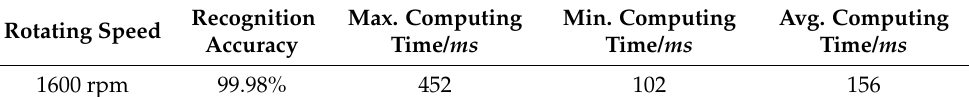
Table 3. Recognition accuracy and computing time of the SNN on Brian2. Rotating Speed